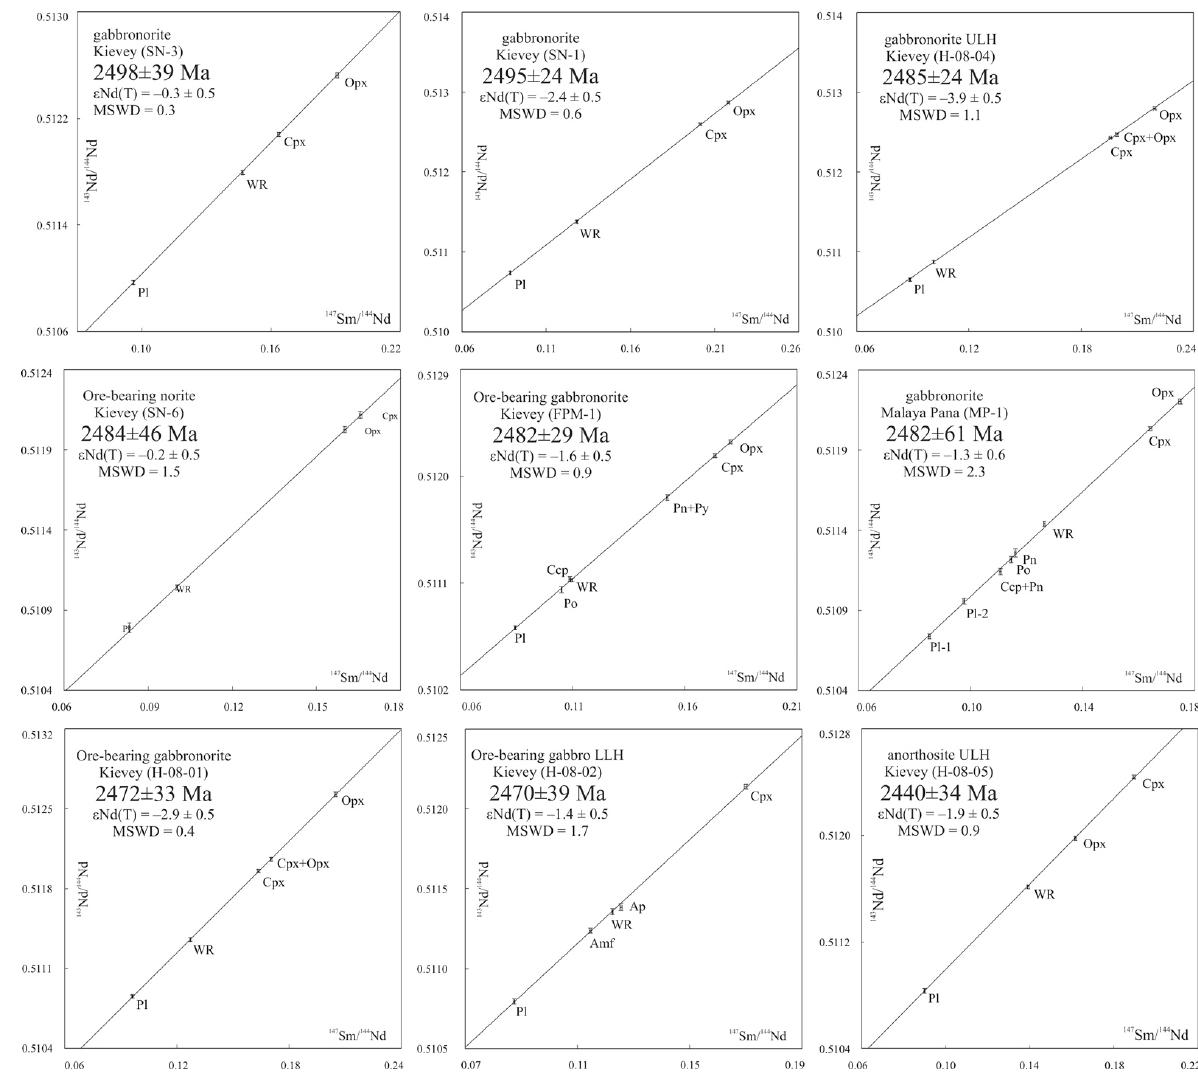
Figure 5. Mineral Sm-Nd isochrones for rocks of the Western Pansky block (Kievey deposit). Clino- and orthopyroxene, plagioclase, and a mixture of pyroxenes were isolated from the ULH gabbronorites sample H-08-04. The Sm-Nd mineral isochron of these minerals and the whole rock combined gives the age of 2485 ± 24 Ma, where ε Nd(T) = − 0.4 ± 0.5 (Figure 5, Table 1). The age is interpreted as the age of crystallization of the upper-layered horizon gabbronorites. Particularly noteworthy is the anorthosite sample H-08-05. These anorthosites host the industrial Pt-Pd mineralization of the upper-layered horizon. Rock- forming minerals, i.e., plagioclase and clinopyroxene, were isolated from sample H-08-05 for Sm-Nd studies. In conjunction with the whole rock, they form a Sm-Nd mineral isochron with the age of 2442 ± 74 Ma (Figure 5, Table 1). From the literature, the U-Pb age (in baddeleyite) of these anorthosites is 2447 ± 12 Ma [24]. Yet, recent analyses